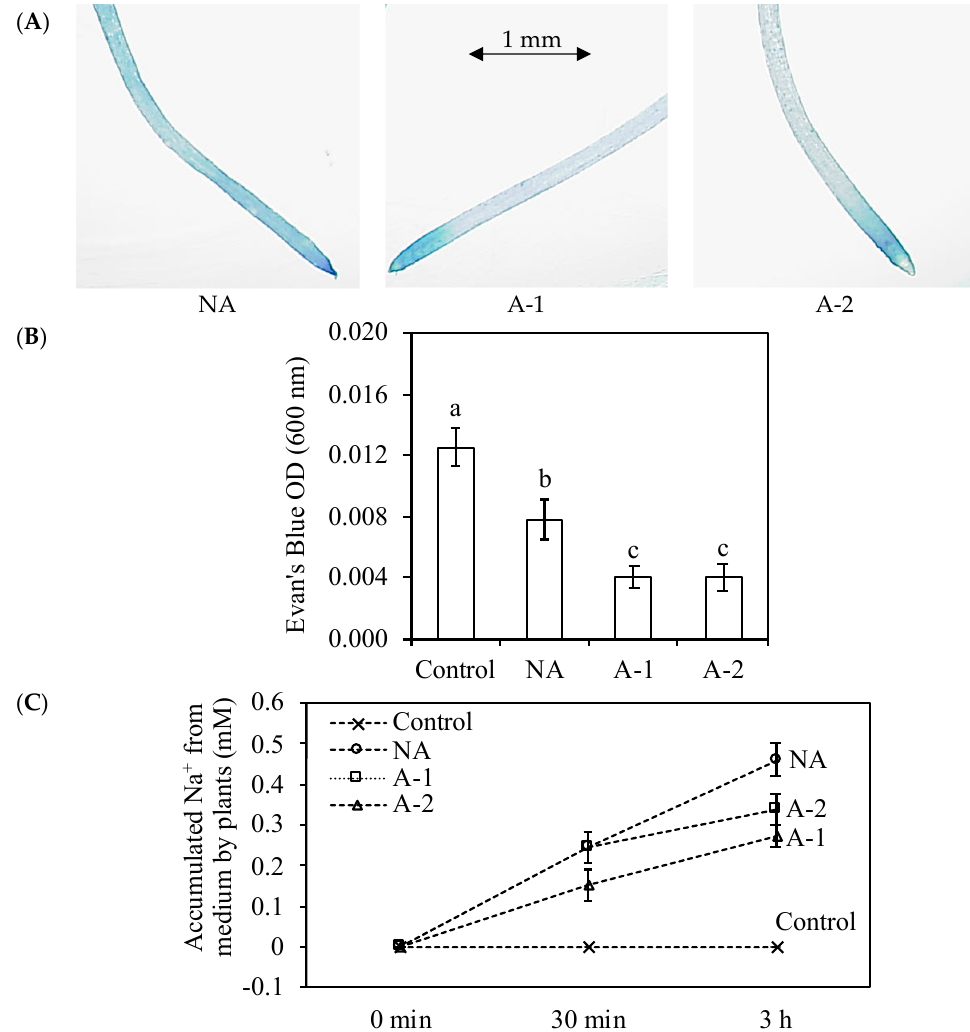
Figure 5. Effects of 30 min sodic-alkalinity with 10 mM NaHCO 3 on the Evan’s Blue staining of the root tips of pre-acclimated rye ( A ), and effects of 2 h sodic-alkalinity with 10 mM NaHCO3 on the quantification of the Evan’s Blue of the root tips of pre-acclimated rye ( B ). Effects of 30 min and 3 h sodic-alkalinity with 10 mM NaHCO 3 on the Na + accumulation of pre-acclimated rye ( C ). Rye plants were pre-acclimated by 0 (NA) and 0.1 and 0.2 mM NaHCO 3 (A-1, A-2) for 5 days. Control plants were consistently irrigated by nutrient solution. Significance testing was performed using ANOVA analysis followed by Duncan’s multiple range test at p ≤ 0.05. The values are means (±SE) of five replicates. Means followed by the same letter are not significantly different. OD means the optical density of samples measured at a 600 mm wavelength.